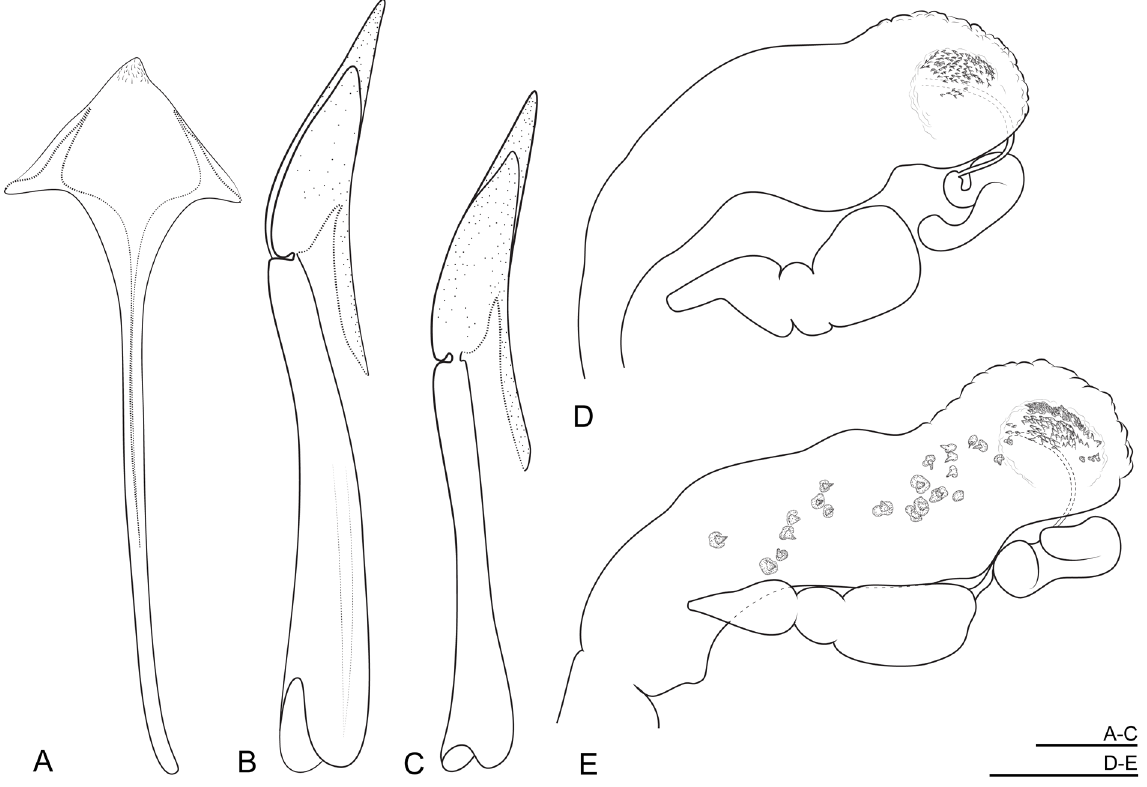
Fig. 9. Female terminalia. A–B, D . Elmomorphus brevicornis Sharp, 1888 (JKCB). A . Sternite VIII. B . Ovipositor. C, E . Elmomorphus amamiensis Nomura, 1959 (JKCB). C . Ovipositor. D . Bursa copulatrix. E . Bursa copulatrix. Scale bars = 0.1